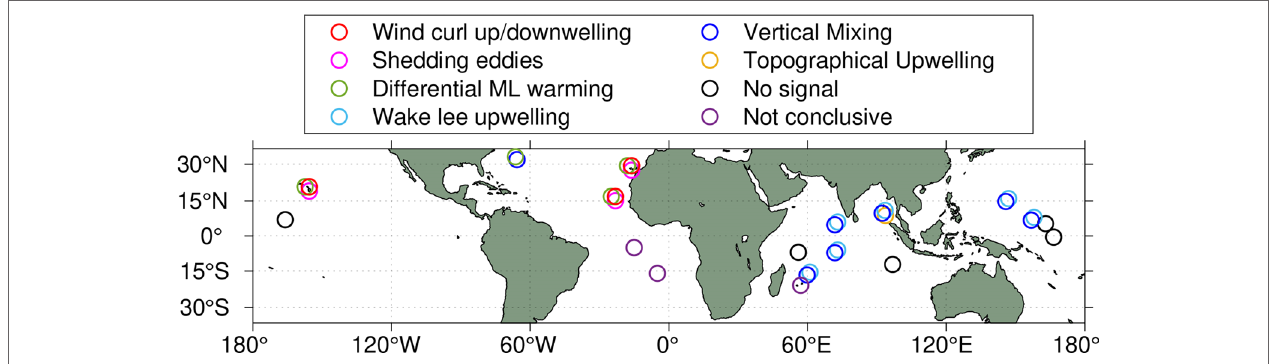
FIGURE 1 | Analysed islands and archipelagos and prevailing physical processes that enhance vertical exchanges in the surrounding